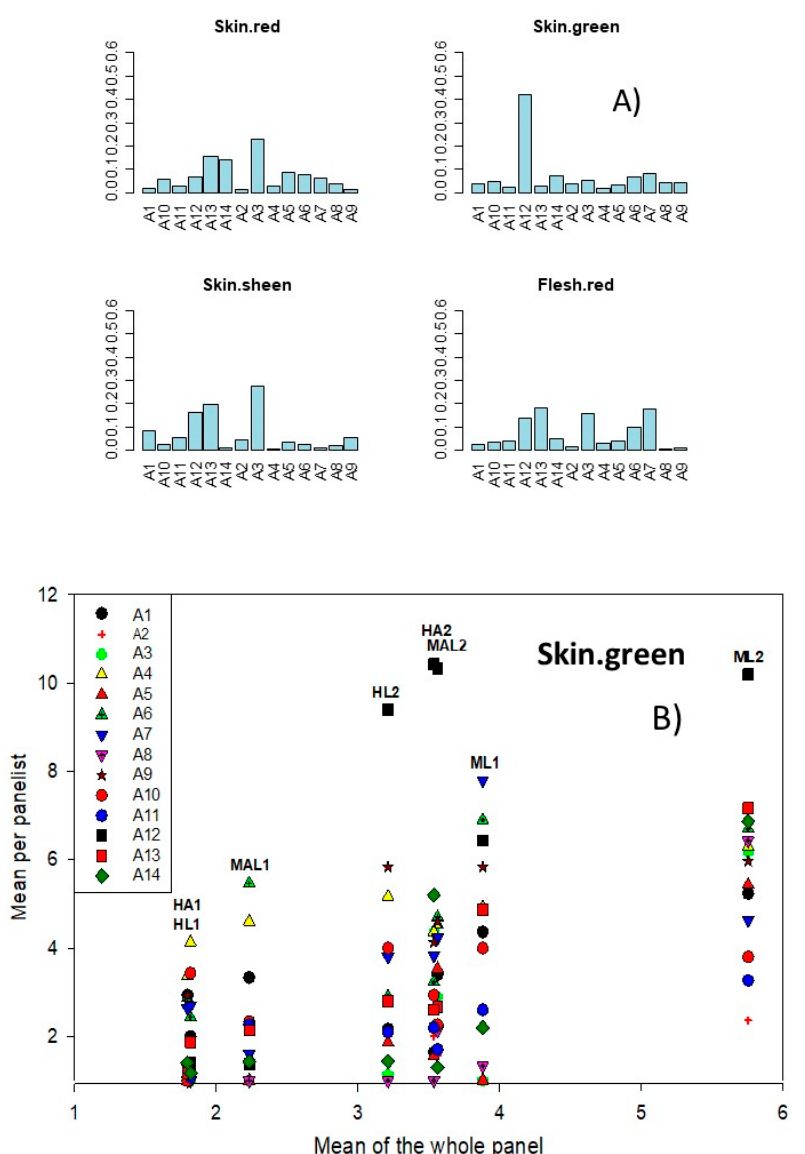
Figure 2. Panel performance. Sample·panelist interaction as assessed by ( A ) the panelist’s contributions (coefficients) for selected descriptors (skin red, skin green, skin sheen, and flesh red), and ( B ) means of panelists over the whole panel according to samples.